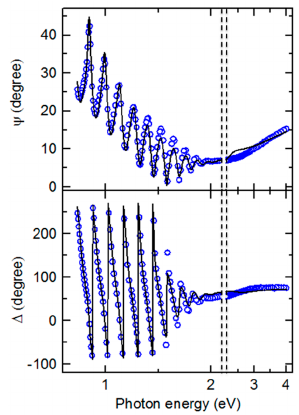
Figure 7. Ellipsometric spectra (points) obtained in-situ at the end of an IGS deposition at a substrate temperature of 400 °C before initiation of the second stage of CIGS deposition. Also shown is the best fit (solid lines) using the structural model and best fit parameters of Figure 8. Different linear scales are used over the ranges of 0.74–2.1 eV and 2.1–4.0 eV for greater clarity of the fringe pattern.